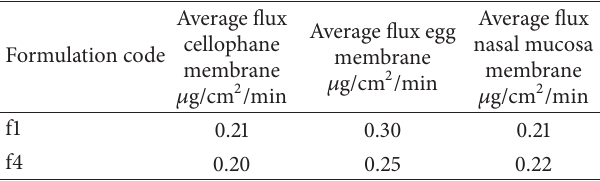
Table 8: Flux of in situ nasal